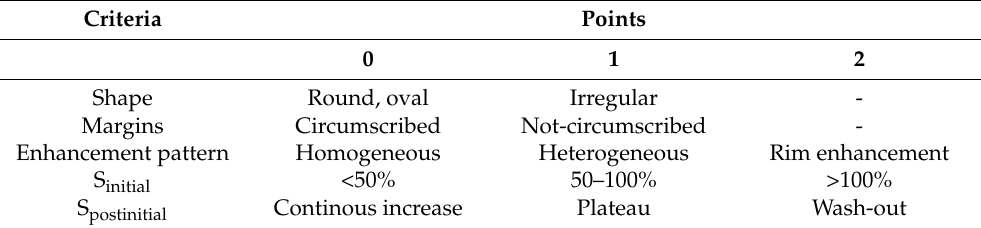
Table 1. Göttingen score (GS) for the evaluation of mass lesions